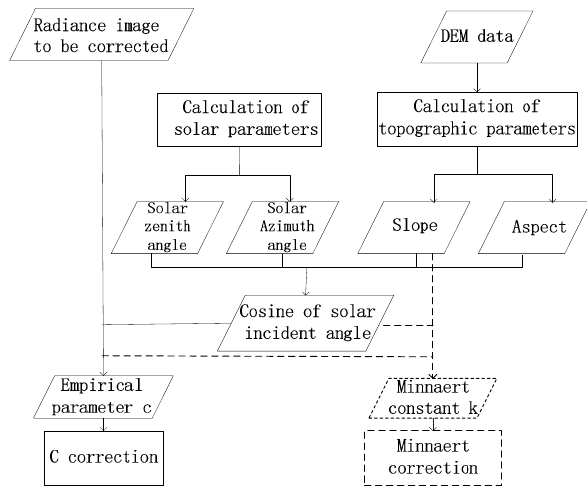
Figure 2. Data link of the two topographic correction models.